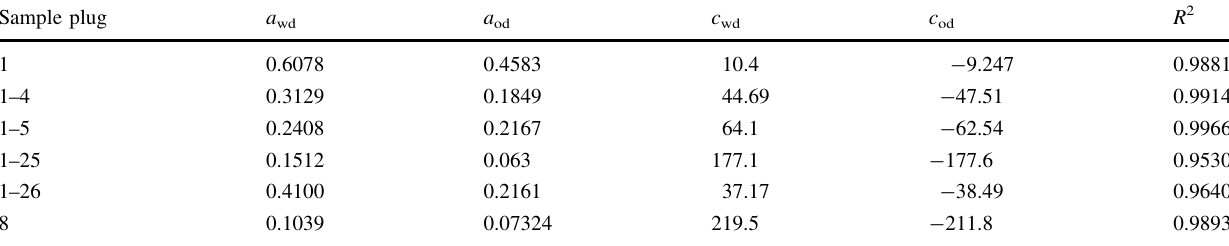
Table 3 Results of fitting constants for secondary